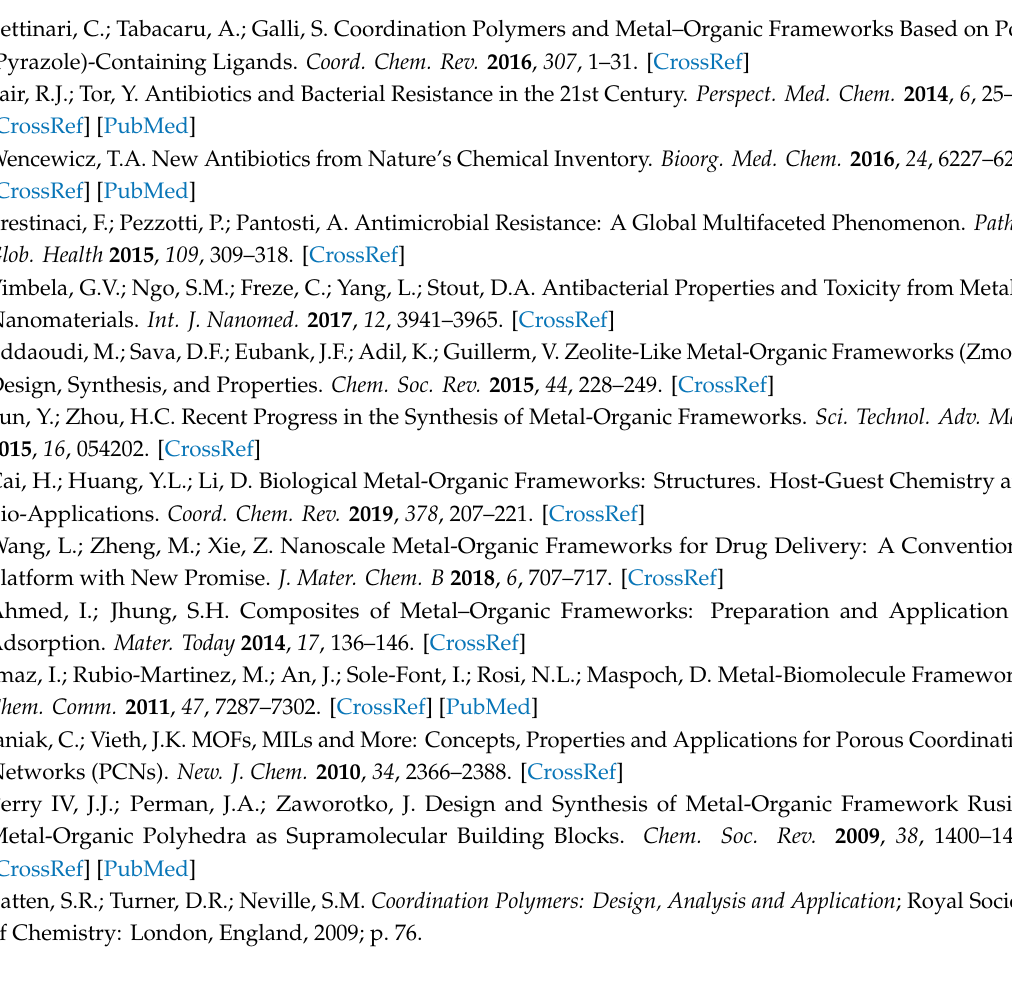
Figure S1. PXRD patterns of 1 . Figure S2. PXRD patterns of 2